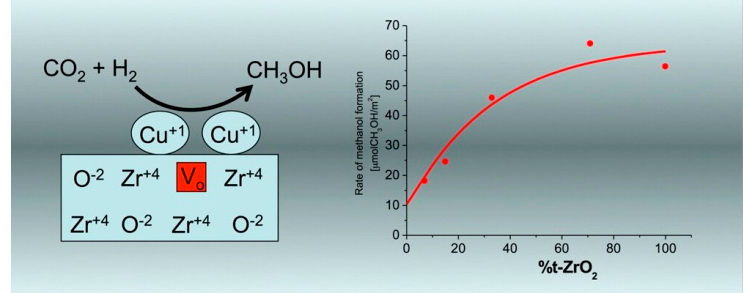
Figure 3. E ff ect of the percentage of t-ZrO 2 on the methanol synthesis rate [9] (https: // pubs.acs.org / Figure 3. Effect of the percentage of t-ZrO 2 on the methanol synthesis rate [9] doi / abs / 10.1021 / cs500979c). Reprinted with the permission of the American Chemical Society, further (https://pubs.acs.org/doi/abs/10.1021/cs500979c). Reprinted with the permission of the American permissions related to the material excerpted should be directed to the ACS. Chemical Society, further permissions related to the material excerpted should be directed to the ACS.